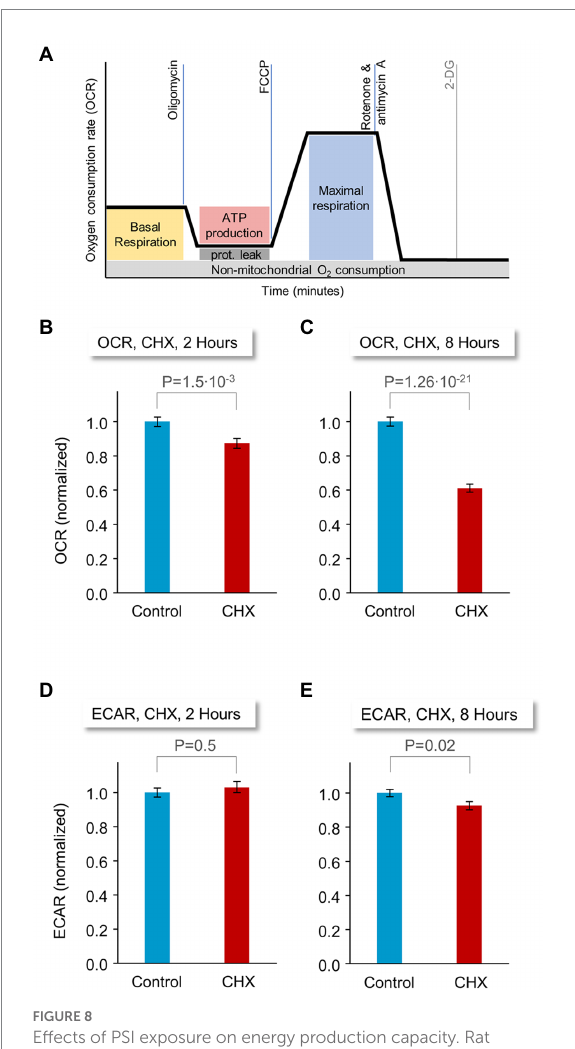
FIGURE 8 Effects of PSI exposure on energy production capacity.